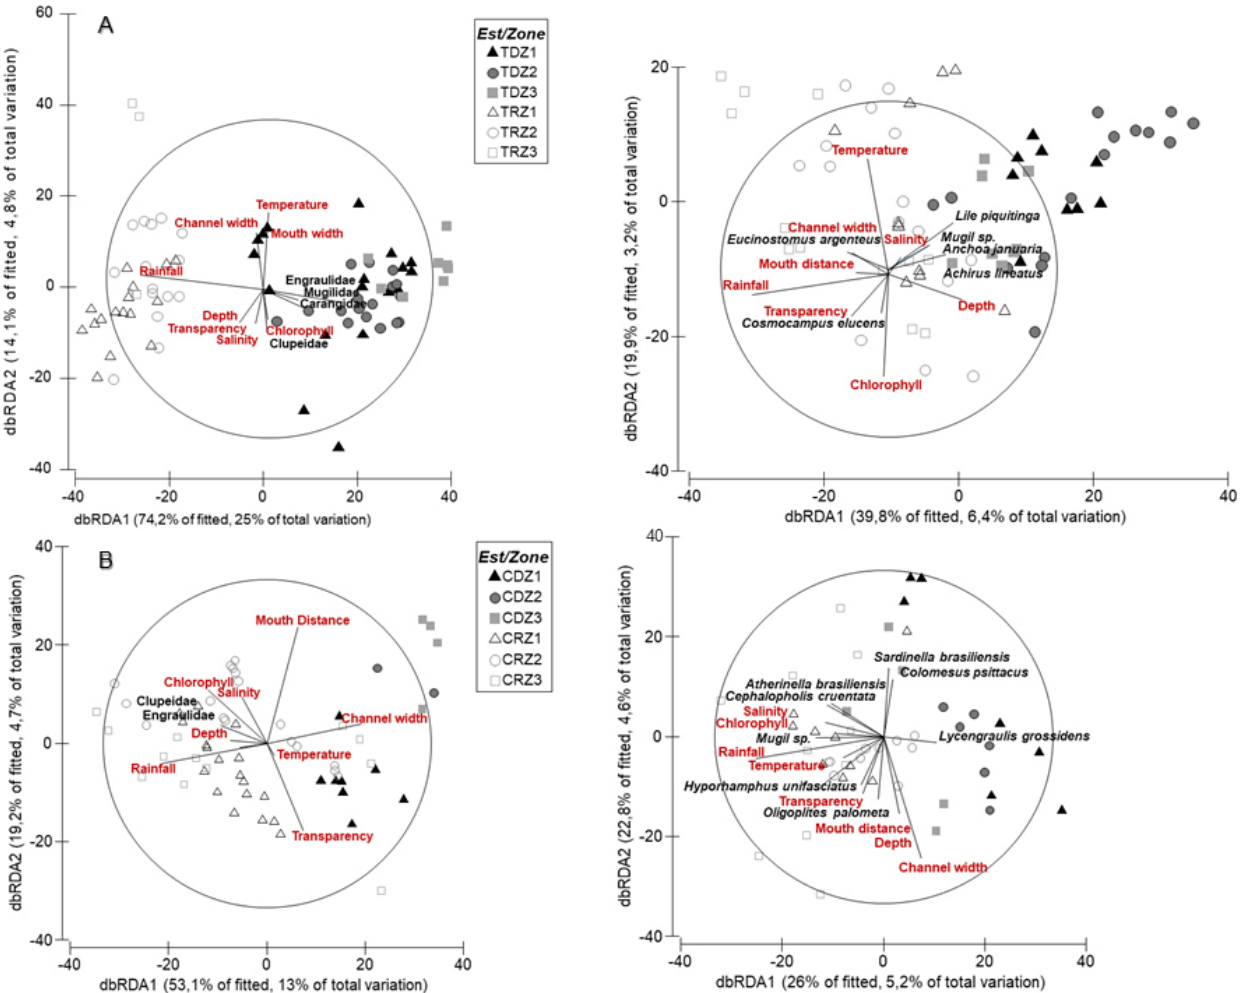
FIGURE 3 | Distance-based redundancy analysis (dbRDA) showing distribution of eggs and larvae by influence of environmental parameters on A. Tubarão (T) and B. Casqueira river estuaries (C) during seasons (D = dry and R = rainy) and zones (Z1, Z2,